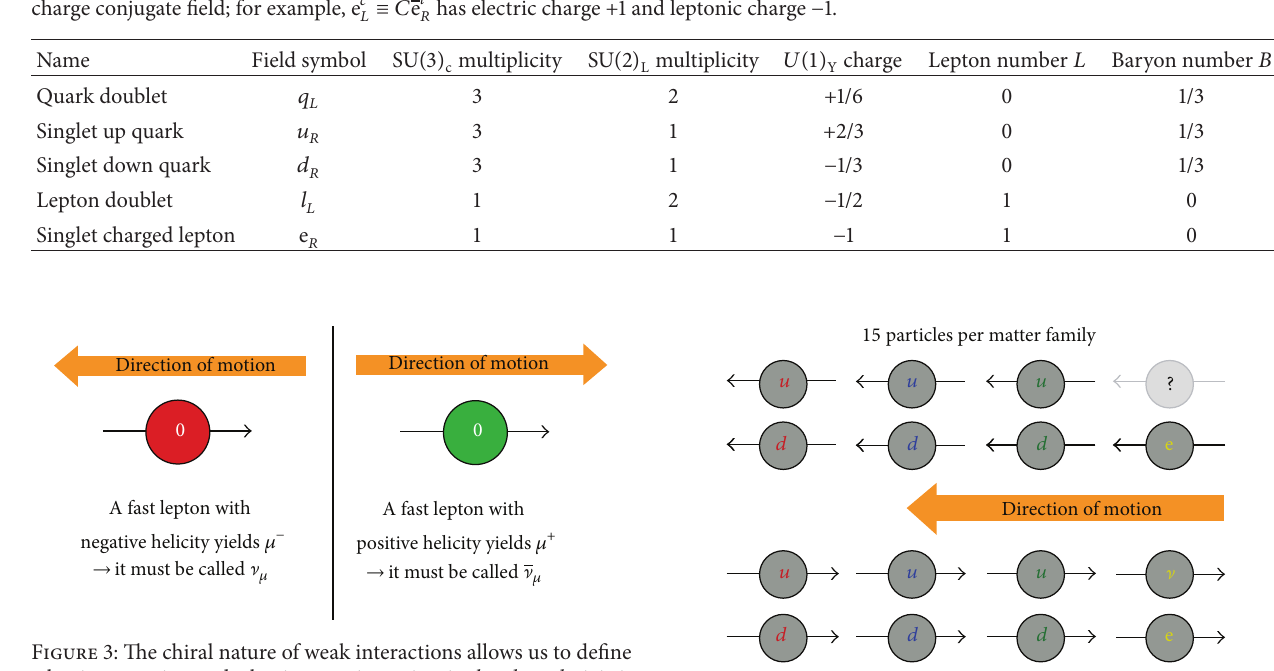
Figure 4: Helicity of the 15 massless matter particles contained in each family of the SM (see Table 1). The arrow gives the direction of the